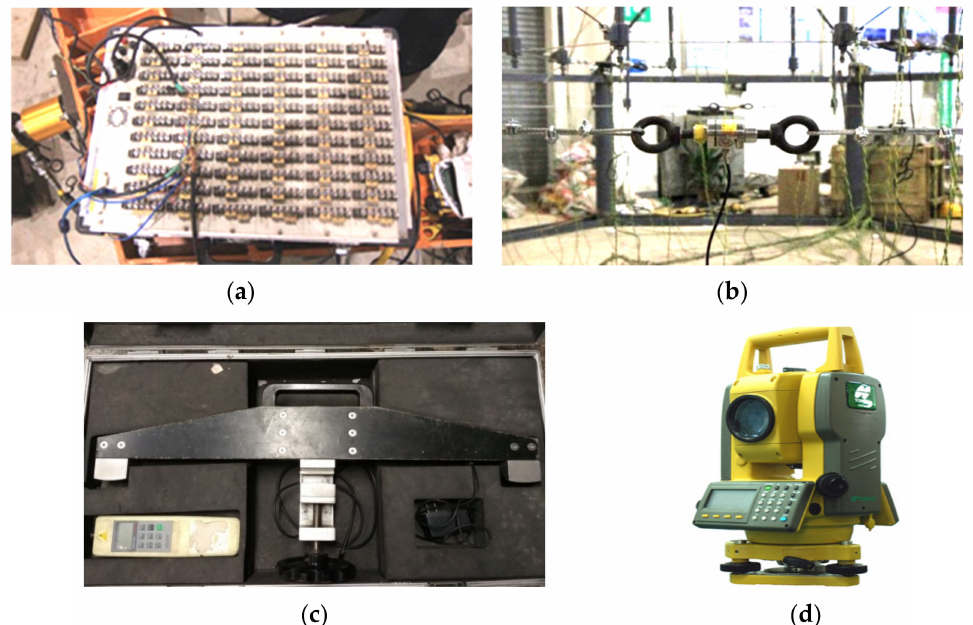
Figure 11. Test and measurement instrument. ( a ) DH3816 static strain test system; ( b ) Tension sensor; ( c ) Tensiometer; ( d ) Total station.